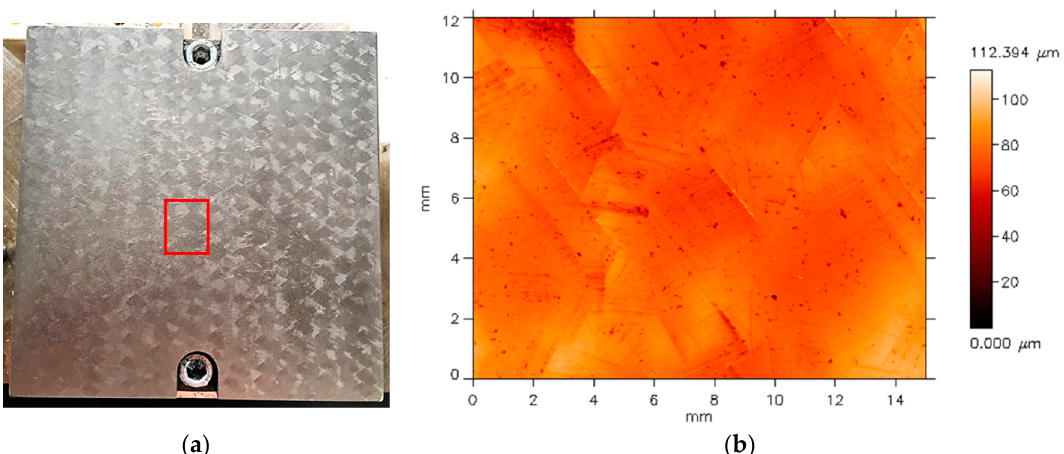
Figure 5. ( a ) Photograph of the workpiece after scraping (first cut) and ( b ) 3D surface scan of the workpiece surface (section marked in ( a ) and rotated by 90° ccw).